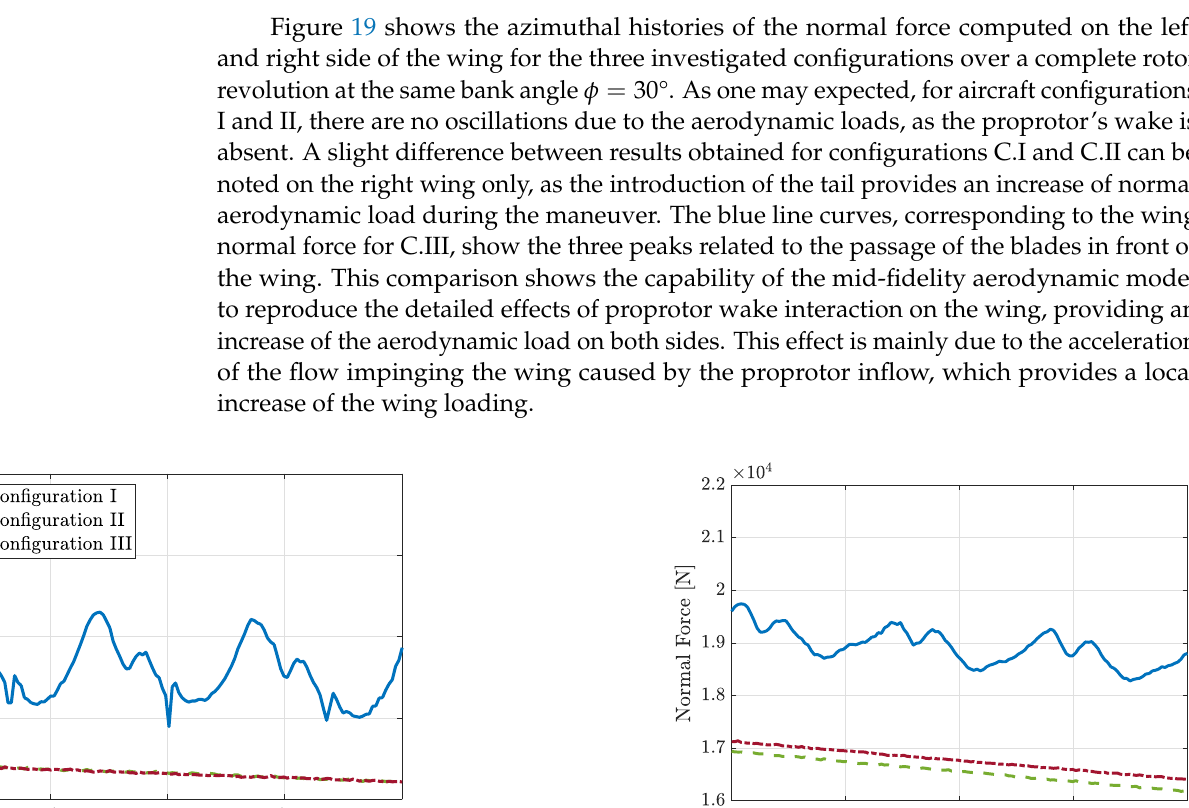
Figure 18. Convention adopted for the rotor blade azimuthal angle ψ .